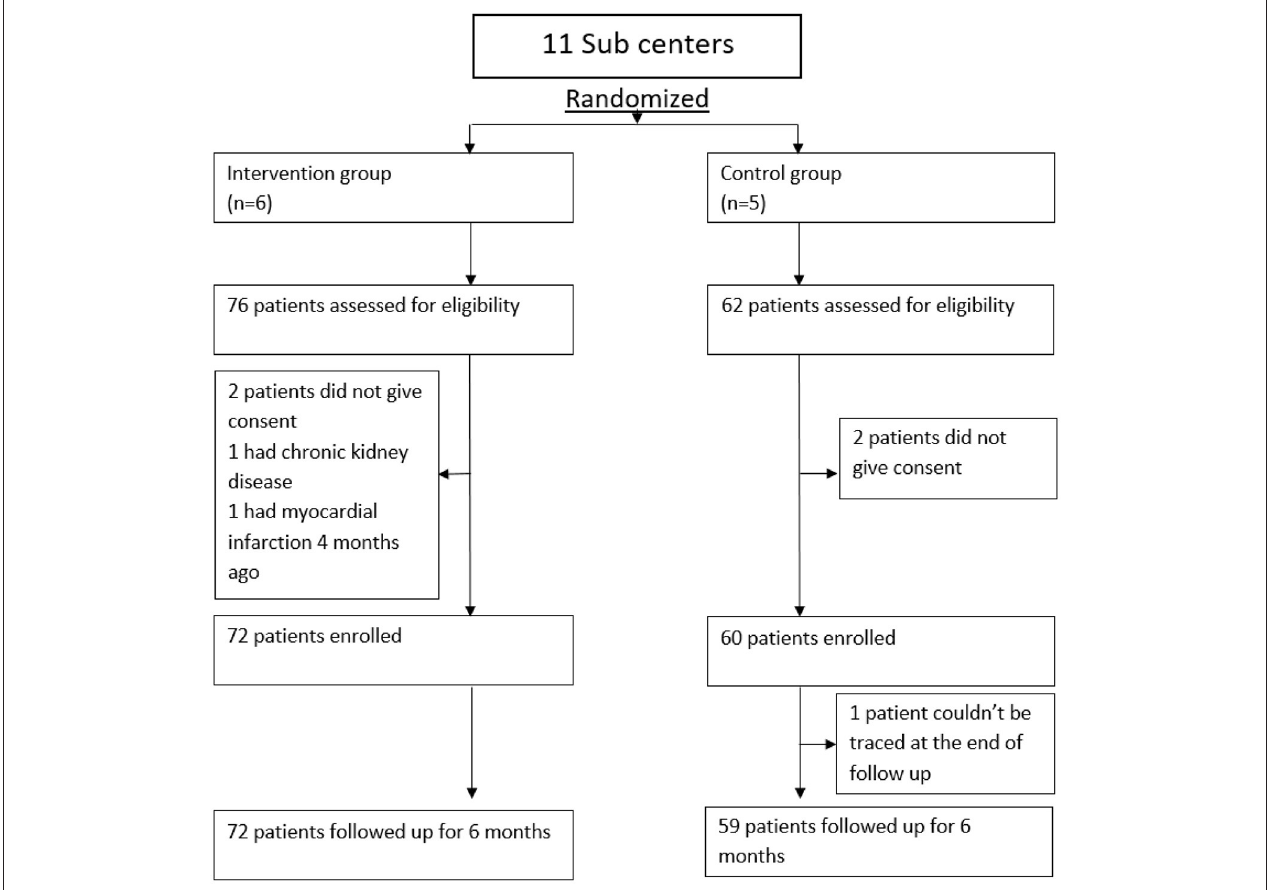
FIGURE 1 | Study enrolment